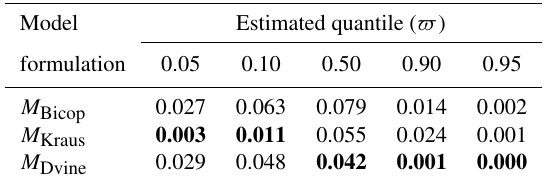
Table 3. Results of average coverage error (ACE) over the valida- tion periods under the synthetic experiment for comparing copula- based model formulations. The best metric values for each quantile are shown in